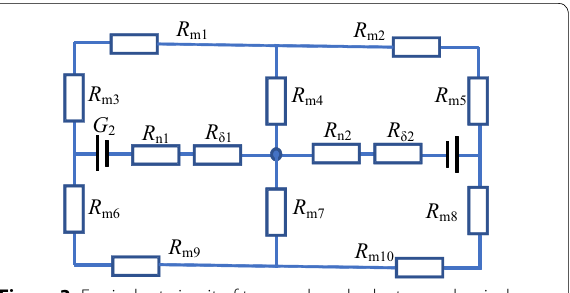
Figure 3 Equivalent circuit of two push-rods electromechanical